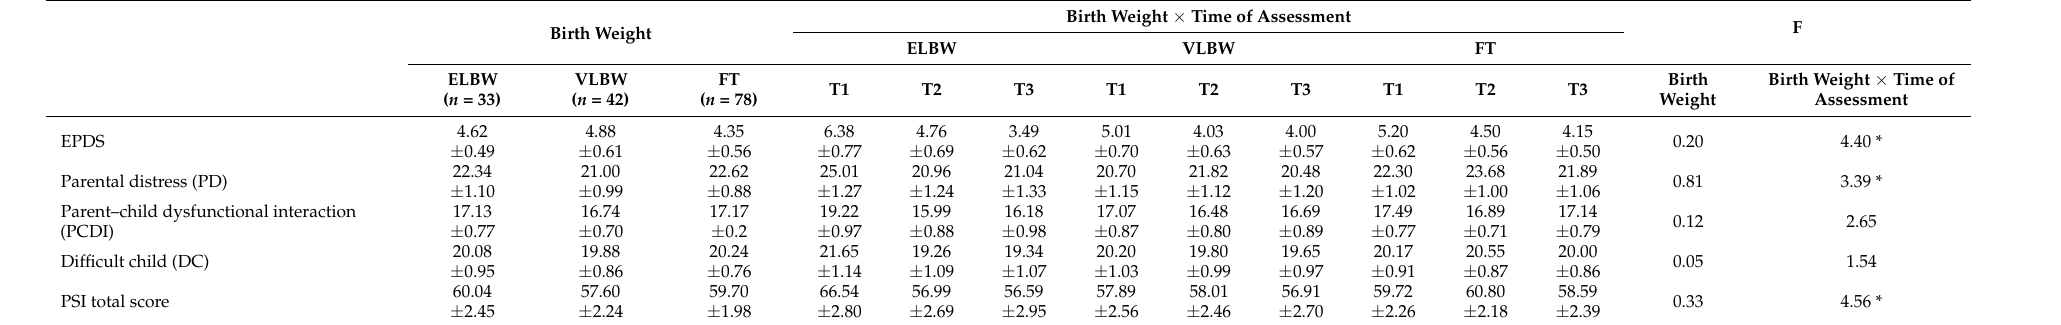
Table 2. Fathers’ mean scores for EPDS and PSI-SF to birth weight and time of